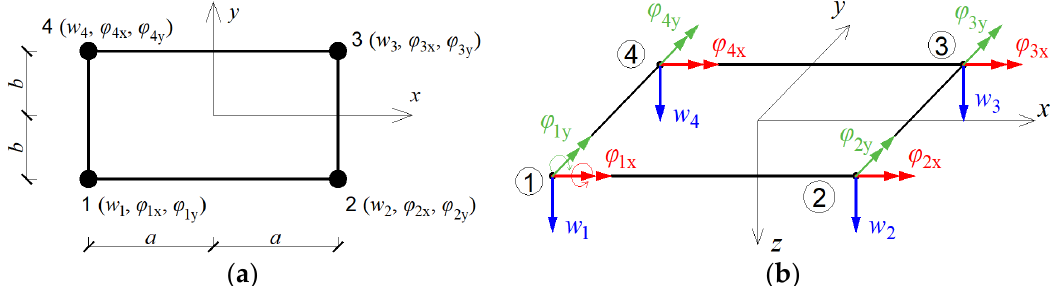
Figure 1. Finite element type plQ4 used for discretization of tested plates. ( a ) Node numbering, ( b ) active degrees of freedom.